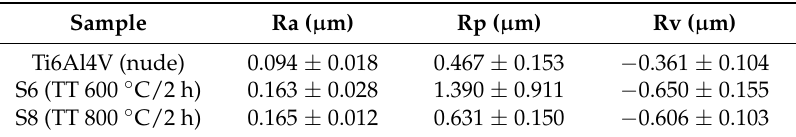
Table 4. Surface roughness parameters for uncoated Ti6Al4V alloy and HAp coated Ti6Al4V alloy thermally treated at 600 ◦ C/2 h and 800 ◦ C/2 h.